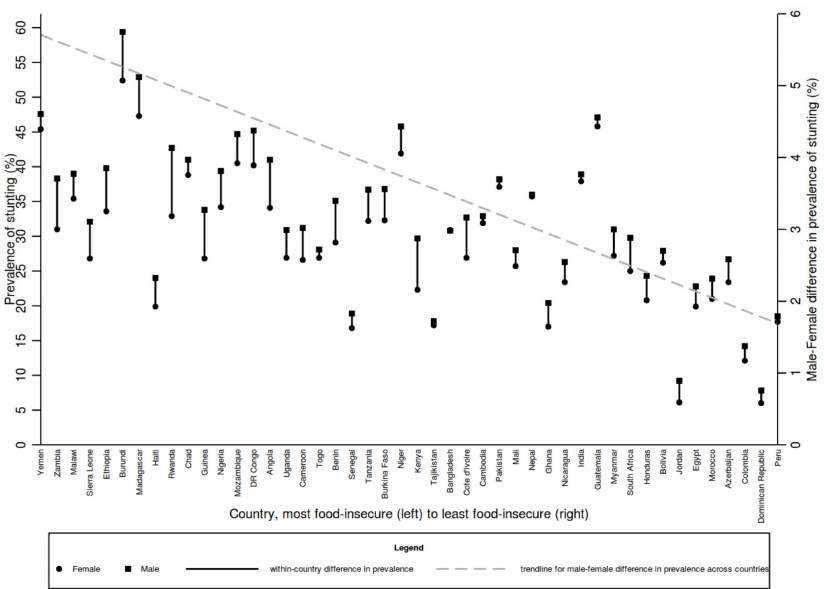
Figure 1. Prevalence of stunting in boys and girls by level of food insecurity. Data sources: Country food security scores from the global Food security index, found at https://foodsecurityindex.eiu. com/Index (accessed on 7 September 2021). Stunting prevalence data from the DHS StatCompiler https://www.statcompiler.com/en/ (accessed on 7 September 2021). The right Y -axis relates to the trendline for the male–female difference in prevalence across